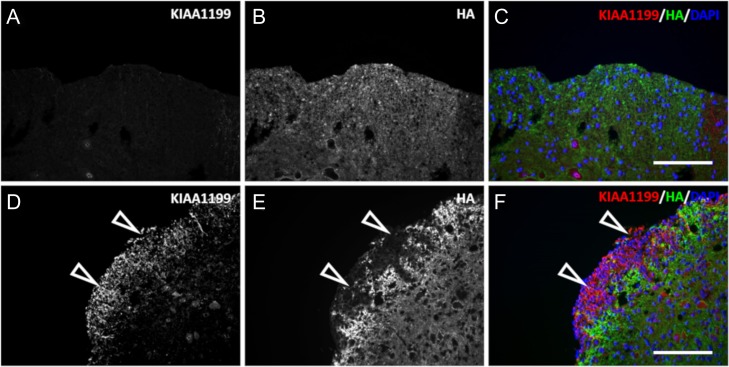
KIAA1199 is colocalized with HA-degraded areas in the EAE lesions. Transverse sections of the spinal cord of control and EAE mice were costained for KIAA1199 (A, D) and HA (B, E). (C) and (F) are the merged micrographs showing HA (green), KIAA1199 (red) and the DAPI counterstain (blue). KIAA1199 is found almost exclusively in the lesions of the EAE in which HA content is degraded (open arrows). KIAA1199 immunolabeling is mostly associated with cell structures (scale bar, 80 μm).